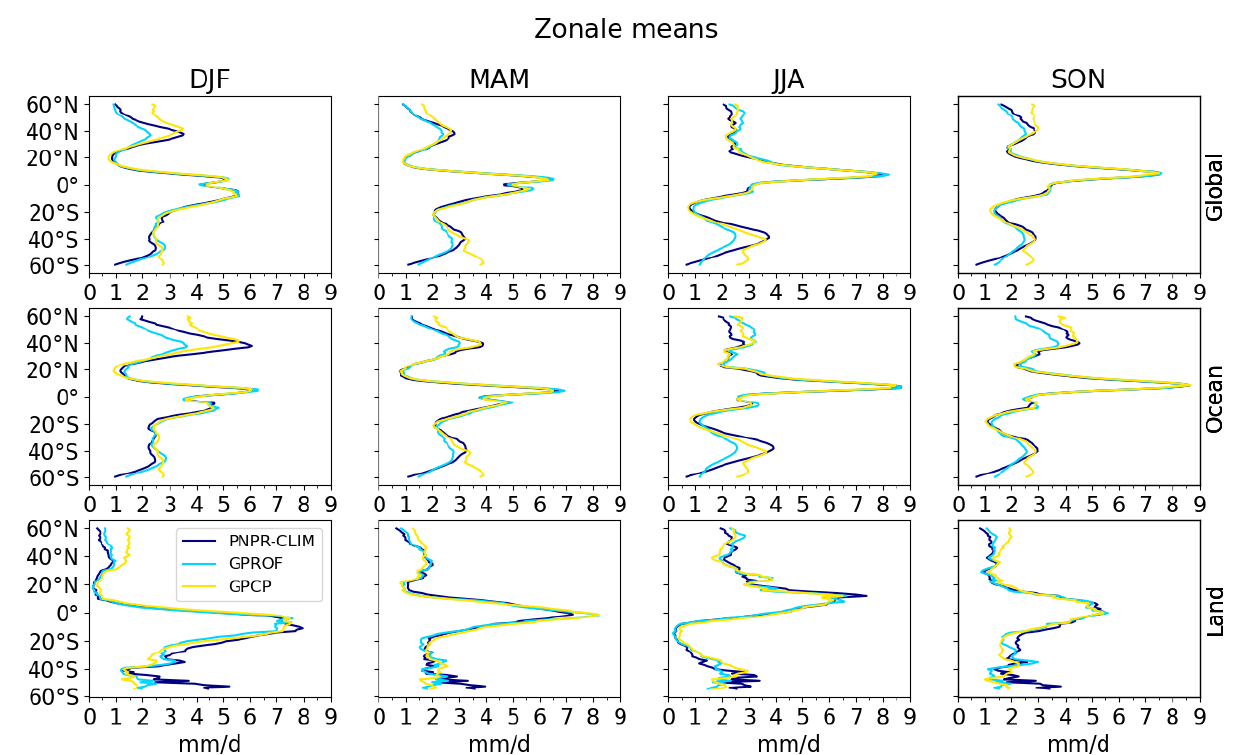
Figure 9. Zonal seasonal means of PNPR-CLIM, GPROF and GPCP over the time period 2015–2017 computed globally ( first row ), over ocean ( second row ) and over land ( third row ) for each season